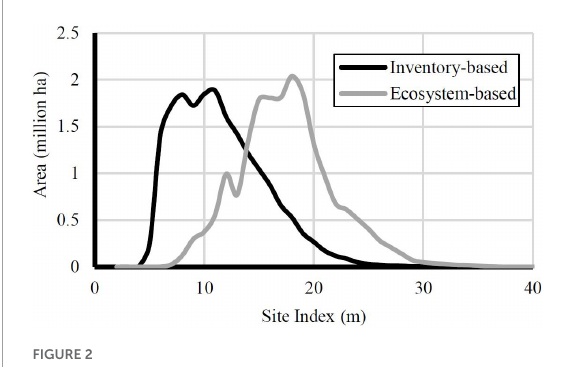
FIGURE2 Distribution of area by inventory-based and ecosystem-based site index for BC’s forests > 140 years.